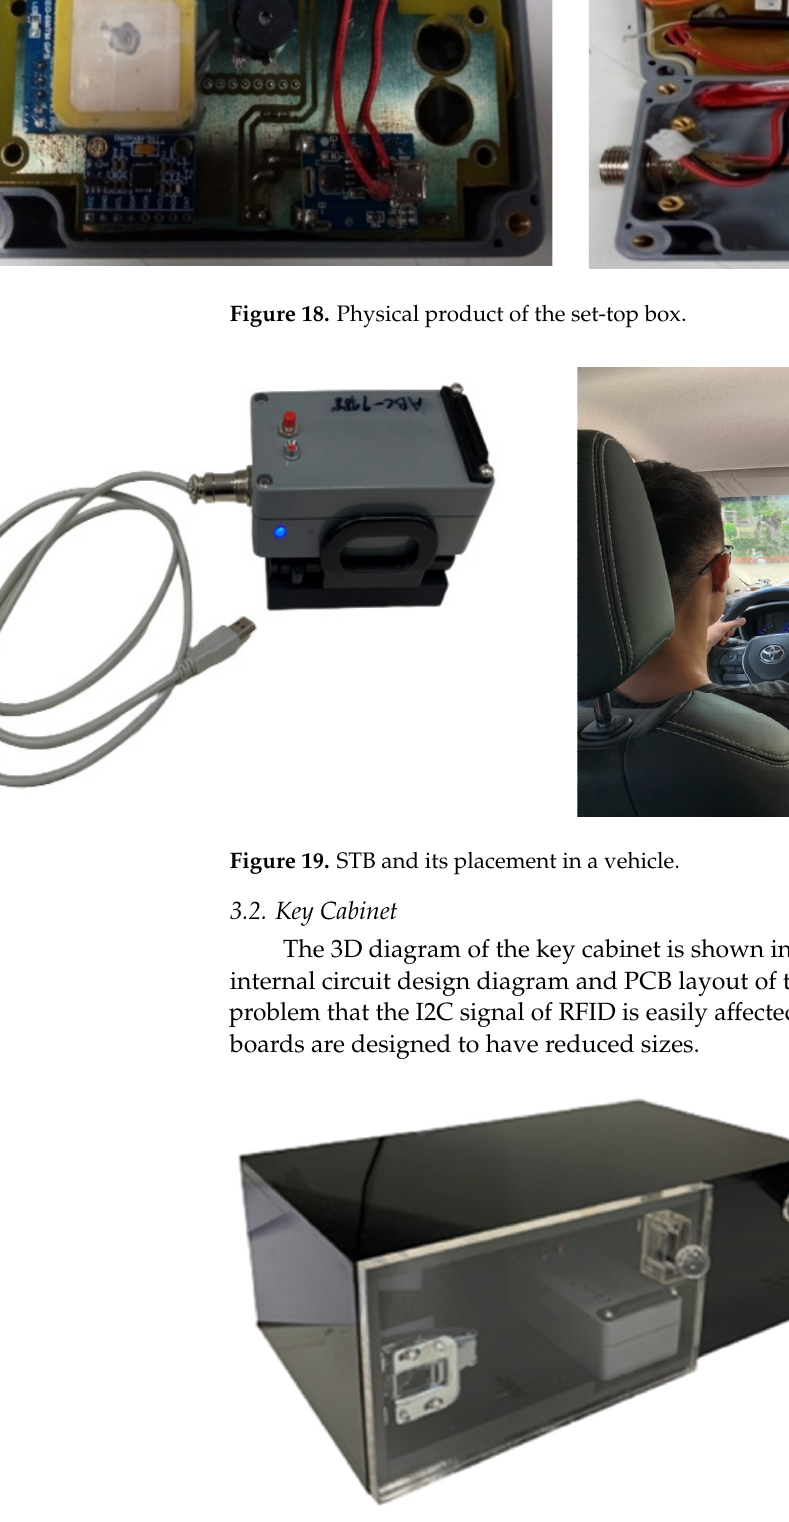
Figure 20. Entity diagram of an independent key cabinet.